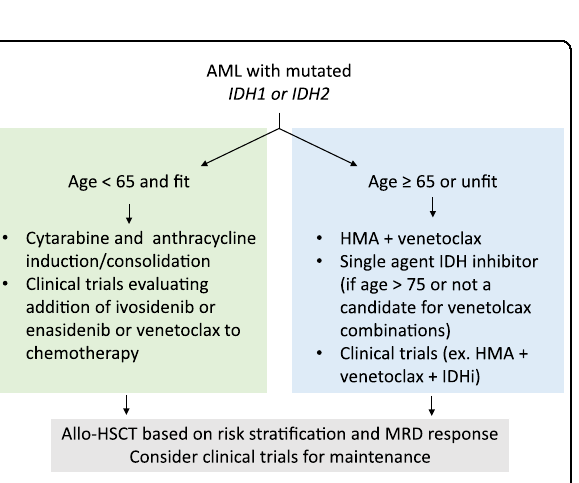
Fig. 2 Treatment algorithm for AML with mutated IDH1 or IDH2 . AML, acute myeloid leukemia; IDH , Isocitrate Dehydrogenase ; HMA, hypomethylating agent; IDHi, IDH inhibitor; Allo-HSCT, allogeneic hematopoietic stem cell transplant; MRD, minimal or measurable residual